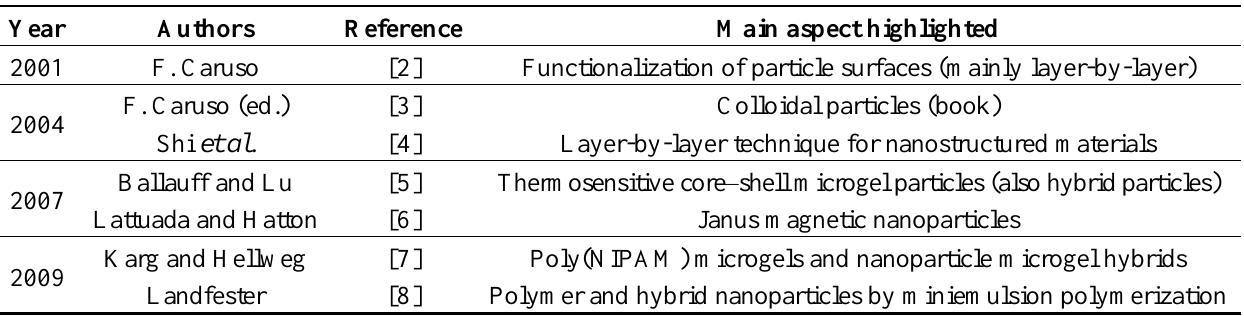
Table 1. Overview publication on specific issues related with the synthesis and applications of hybrid